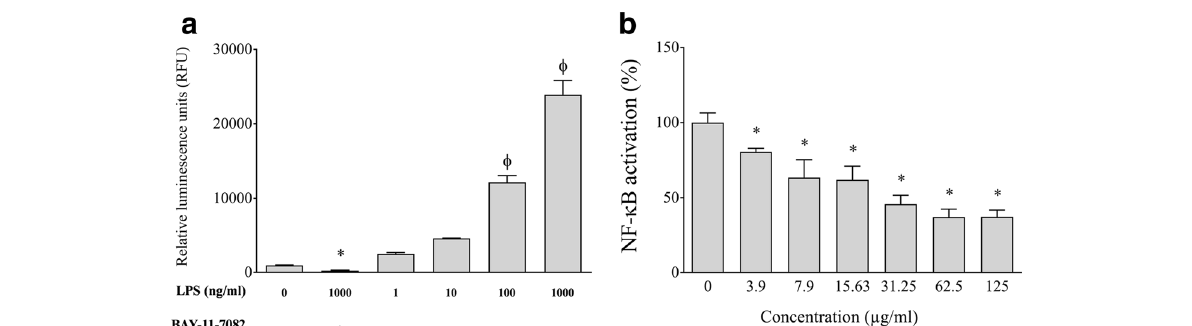
Fig. 9 Effect of A. actinomycetemcomitans LPS in the absence and presence of highbush blueberry PACs on nuclear factor- κ B (NF- κ B) activation using the U937-3x κ B cell model. Panel a Concentration effect of A. actinomycetemcomitans LPS on NF- κ B activation. Panel b Inhibitory effect of highbush blueberry PACs on A. actinomycetemcomitans LPS-induced NF- κ B activation. A value of 100% was assigned to the activation obtained with A. actinomycetemcomitans LPS in the absence of highbush blueberry PACs. BAY-11-7082 was used as a positive inhibitory control. Results are expressed as the mean±SD of triplicate assays from two independent experiments. Φ : significant increase ( p <0.001) compared with nonstimulated control cells. ∗ : significant decrease ( p <0.001) compared with LPS-stimulated cells not treated with highbush blueberry